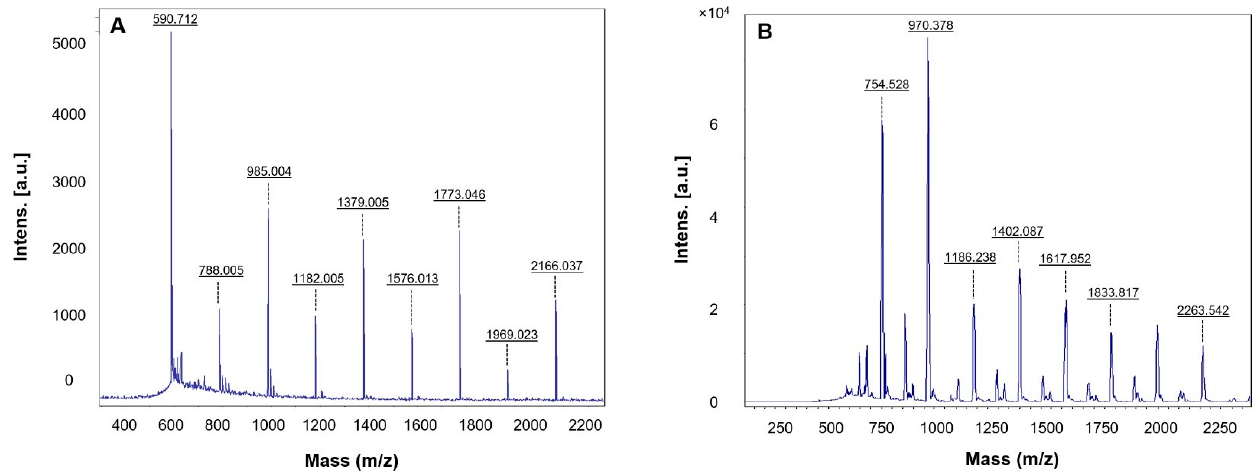
Figure 7. MALDI-TOF analysis of ( A ) RB-AuNPs and ( B ) RB-AgNPs demonstrated respective metal ions.